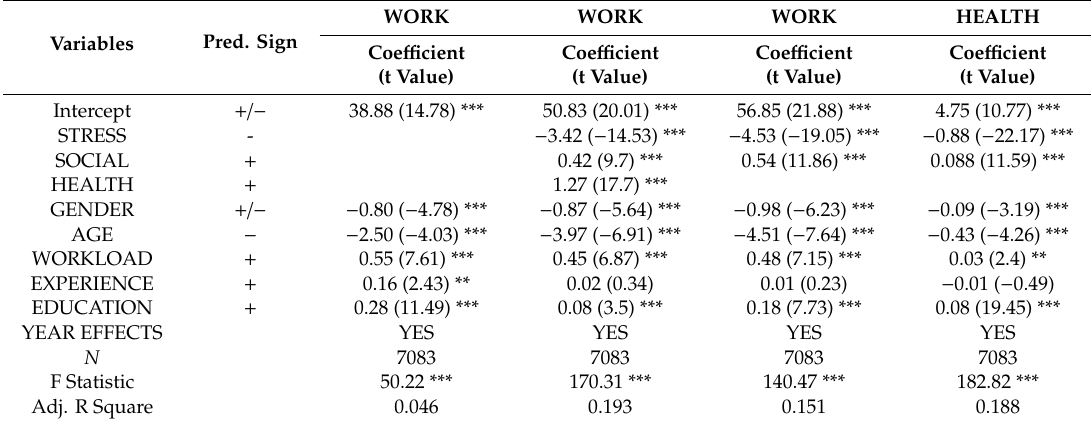
Table 4. Regression analysis of factors a ff ecting work